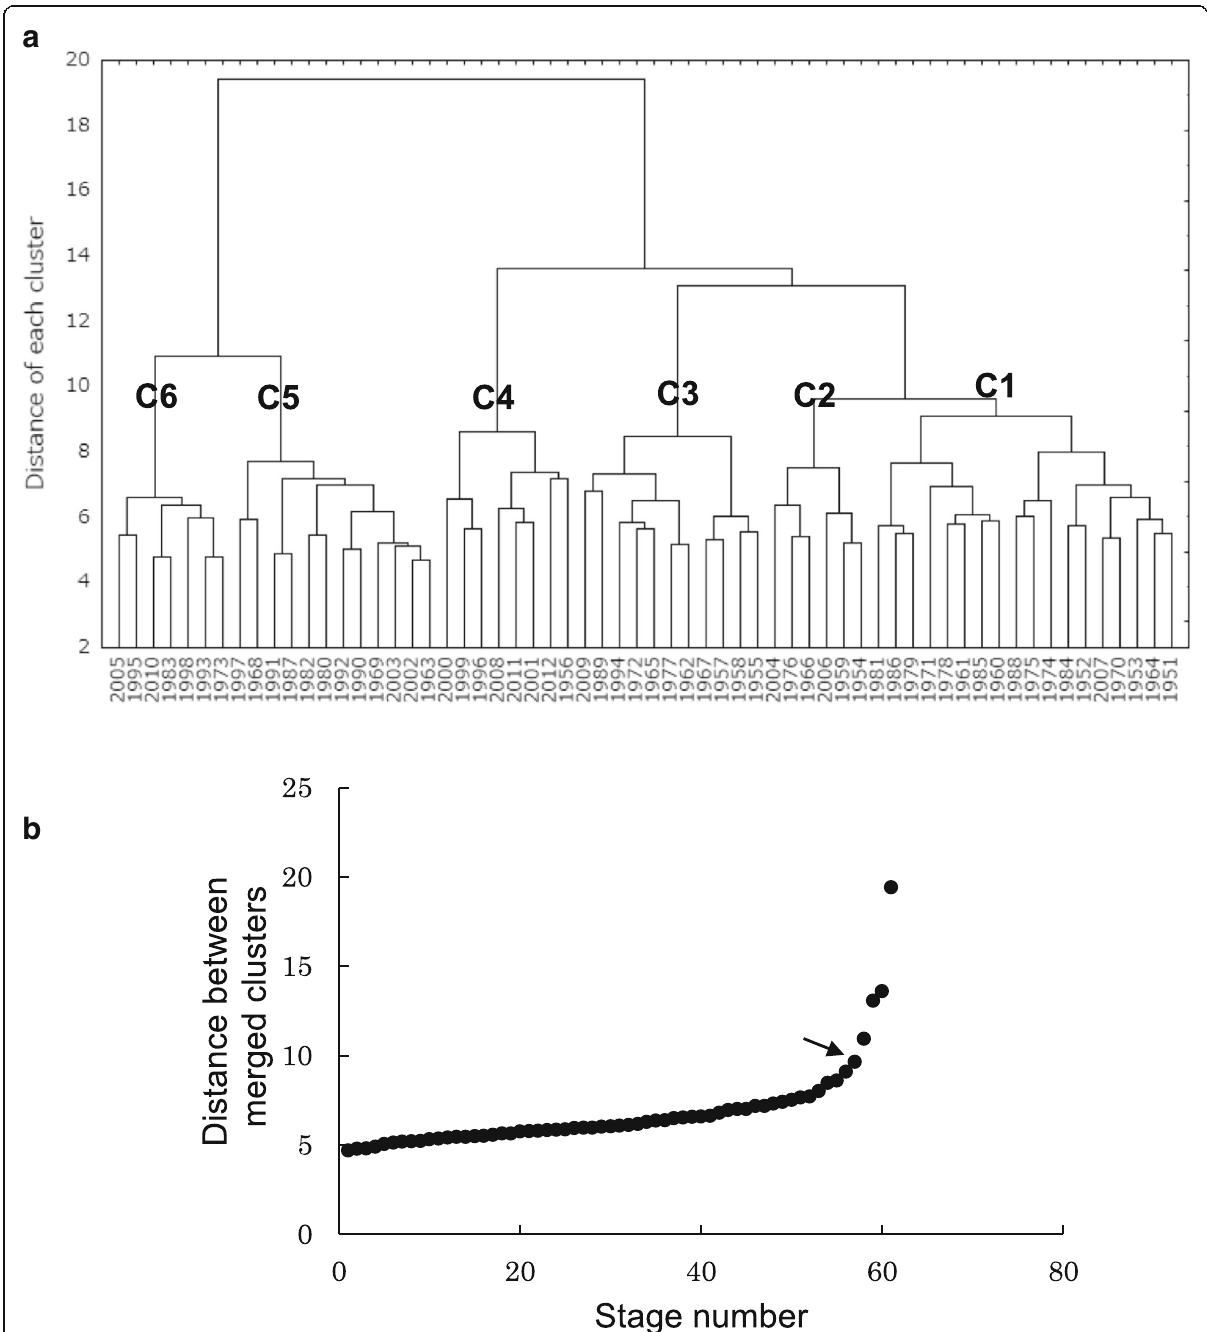
Fig. 2 Dendrogram of cluster analysis to the time coefficients of EOF1 ( a ) and the corresponding plot of the distance between the merged clusters ( b ). The arrow in b indicates the stage number just before distances between the merged clusters become large in the process of cluster